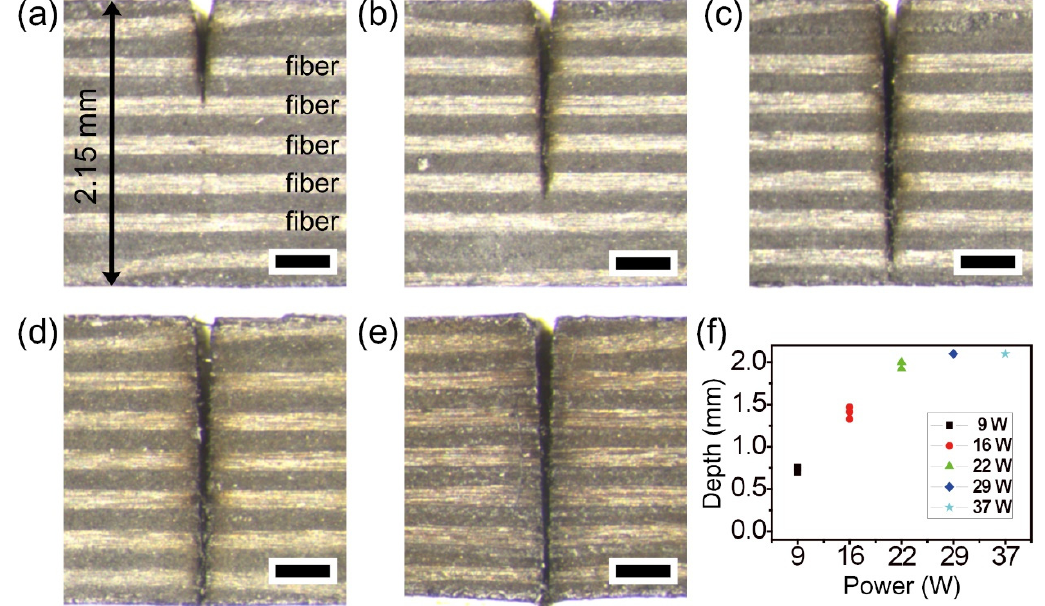
Figure 5. Picosecond laser cutting of the thermoset CFRP with power variation. Stereoscopic microscope cross-section images by a power of ( a ) 9, ( b ) 16, ( c ) 22, ( d ) 29, and ( e ) 37 W, respectively. Each scale bar = 400 µm. ( f ) Graph of cutting depths by power variation. The common experimental conditions were a scan speed of 0.5 m/s, 100 loops, and 10 passes with 10 µm gap.